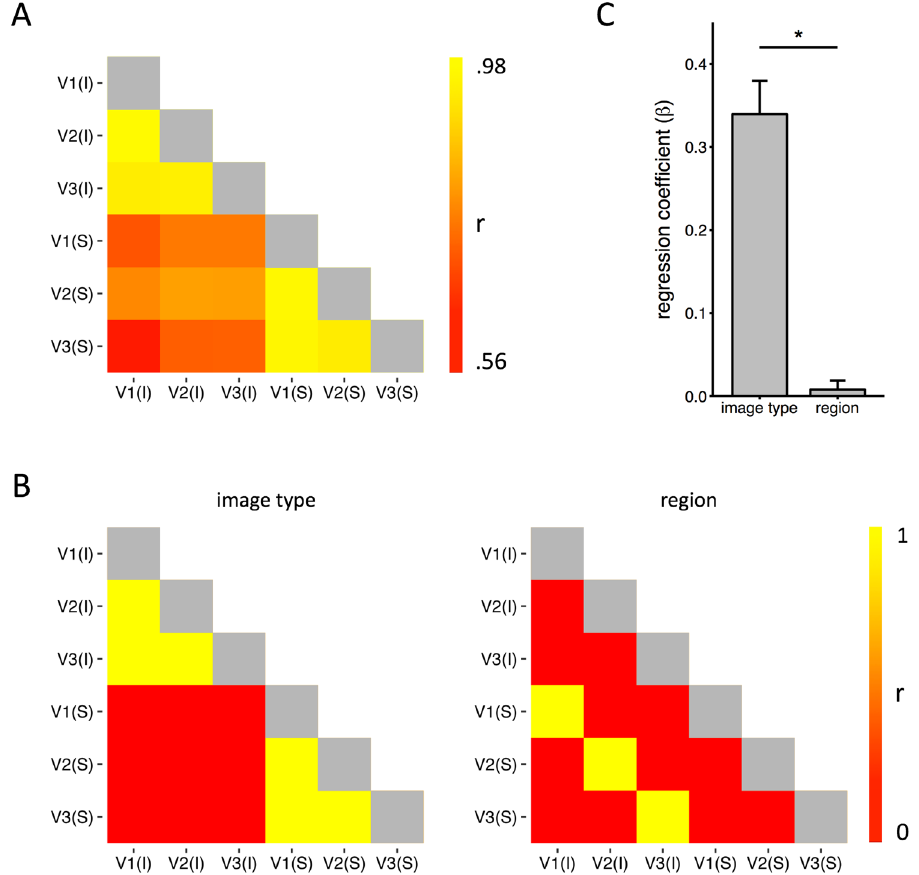
Figure 5. ( A ) Correlations between the similarity matrices shown in Fig. 4A. ( B ) Matrix predictions based on representations of image type and region. ( C ) Models were used in a regression analysis across participants. Performance was determined by the regression coefficients for each model. The results show that patterns of response were predicted significantly more by the image type than region. Error bars show ± 1 SEM. * p <